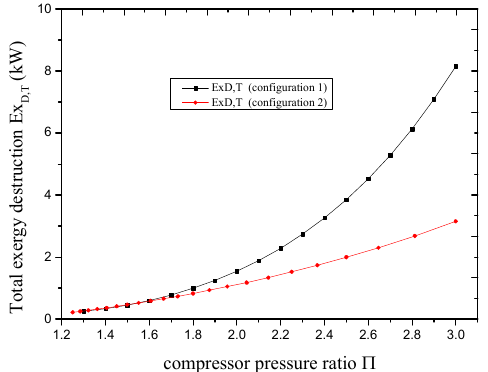
Figure 17. Total exergy destruction versus π at T GEN = 100 ◦ C.